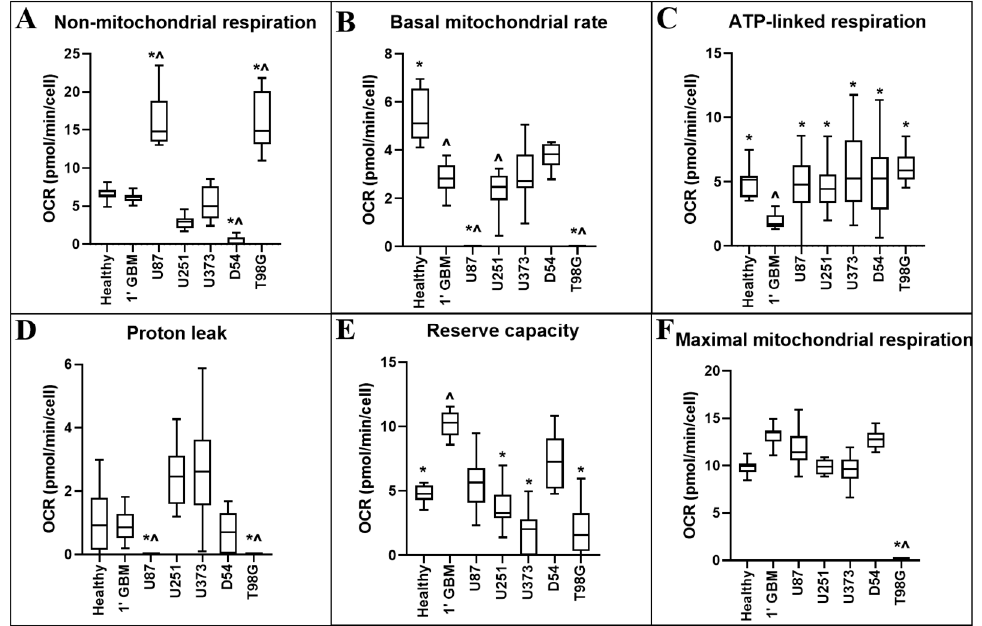
Figure 3. Comparison of OCR-related metabolic parameters of primary neural and GBM cells, and GBM cell lines. OCR-related metabolic parameters: ( A ) non-mitochondrial respiration; ( B ) the basal mitochondrial rate; ( C ) ATP-linked respiration; ( D ) proton leak; ( E ) reserve capacity; and ( F ) maximal mitochondrial respiration were calculated from measurements obtained using information from the Seahorse Bioscience Metabolic Flux Analyser Mito Stress Kit. Data presented represent the mean, with quartile 1 and 3 marked. For all data points in cell lines, n = 5; in primary healthy cells, n = 8; in primary GBM cells, n = 13; plated in triplicate. * represents statistically significant difference with primary glioblastoma control (1 ′ GBM) ( p ≤ 0.05). ^ represents statistically significant difference with between primary healthy mixed neural control (1 ′ Healthy) ( p ≤ 0.05).